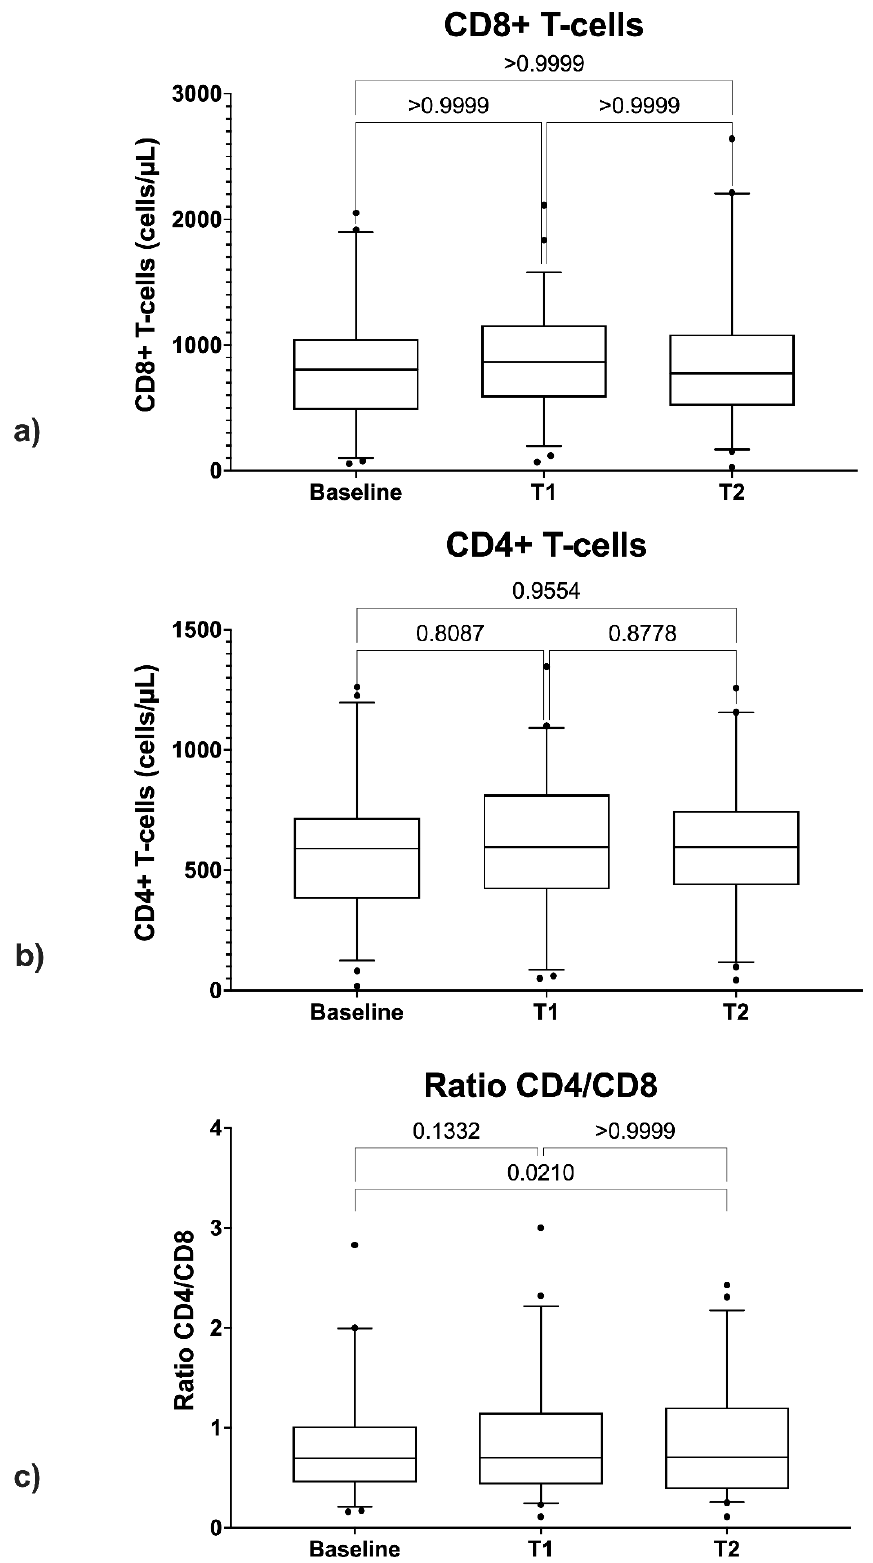
Figure 4. Comparison between CD4+ cells ( a ), CD8+ cells ( b ), and CD4/CD8 ratio ( c ) at baseline, EOT (T1), and SVR48 (T2).